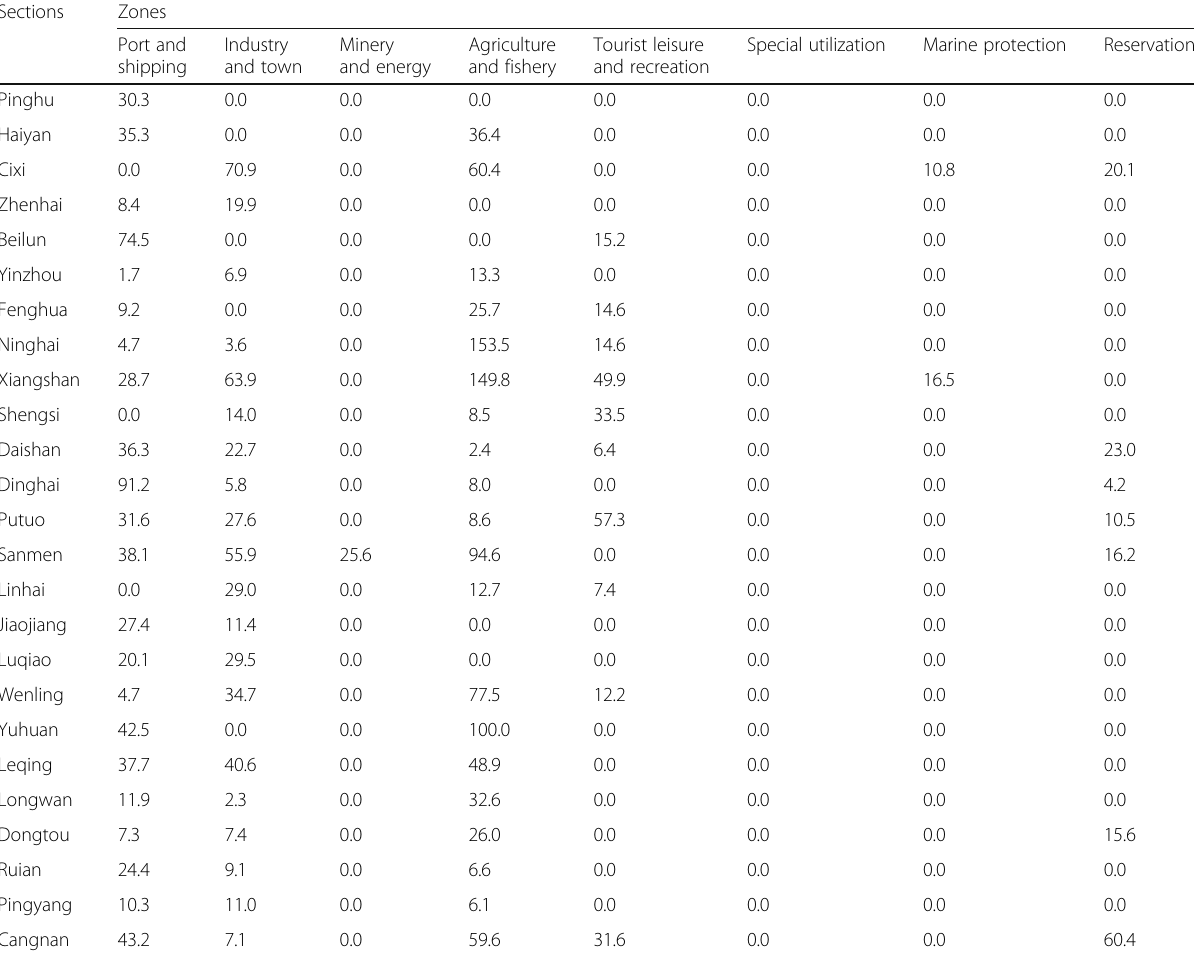
Table 7 The management coastline length adjacent to marine function area of Jiangshu Province. Unit: Km